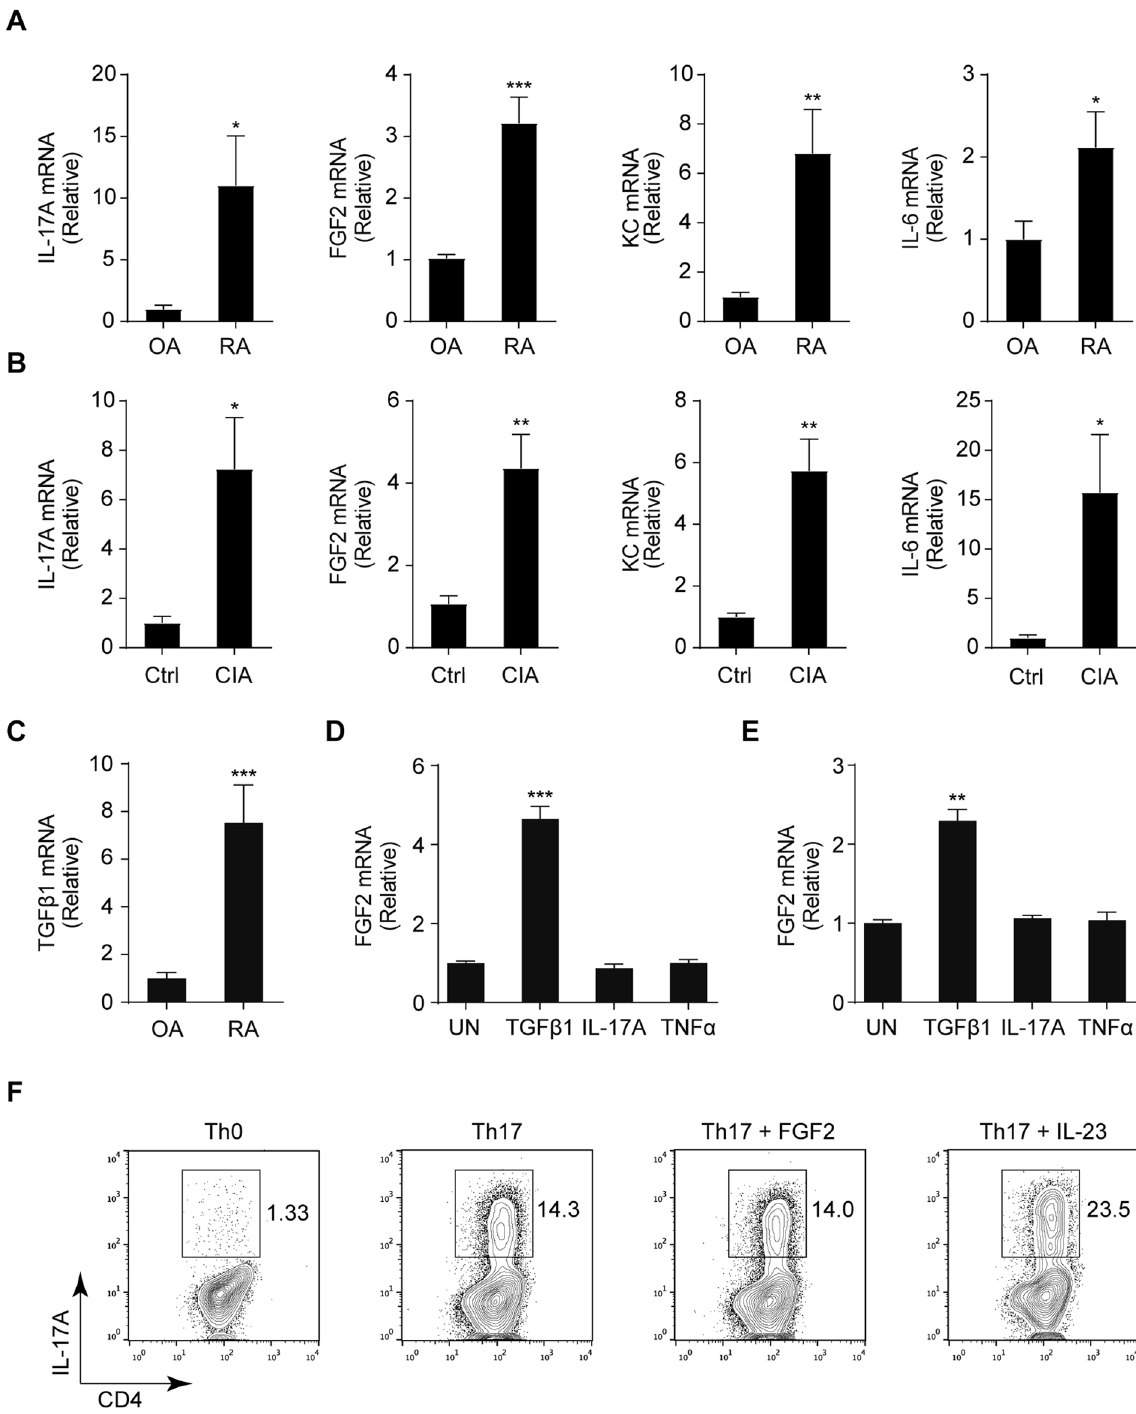
Figure 1. FGF2 and IL-17 are simultaneously elevated in the synovia of RA patients and the joints of CIA model. ( A ) Quantitative mRNA expression of IL-17, FGF2, IL-6 and KC in the synovia from 13 individuals with rheumatoid arthritis (RA) and 12 individuals with osteoarthritis (OA). ( B ) Quantitative mRNA expression of IL-17, FGF2, IL-6 and KC in in joints of wild type C57/BL6 left untreated or treated with the condition for CIA (n = 4). ( C ) Quantitative mRNA expression of TGF β 1 in the synovia from 13 individuals with RA and 12 individuals with OA as in ( A ). ( D and E ) Quantitative mRNA expression of FGF2 in human primary FLS cells ( D ) and MEFs ( E ) left untreated (UN) or stimulated for 6 hr with TGF β 1 (20 ng/ml), IL-17A (100 ng/ml) or TNF α (20 ng/ml). Cells were serum-starved for 16 hr before treatment. ( F ) IL-17A levels in in vitro - differentiated Th17 cells by TGF β 1 (2 ng/ml) and IL-6 (40 ng/ml), with or without FGF2 (20 ng/ml) or IL-23 (20 ng/ml). Data are representative of three independent experiments in ( B , D – F ). Data represent means and s.e.m. in ( A – E ) * P < 0.05, ** P < 0.01, *** P < 0.001 by Student’s t